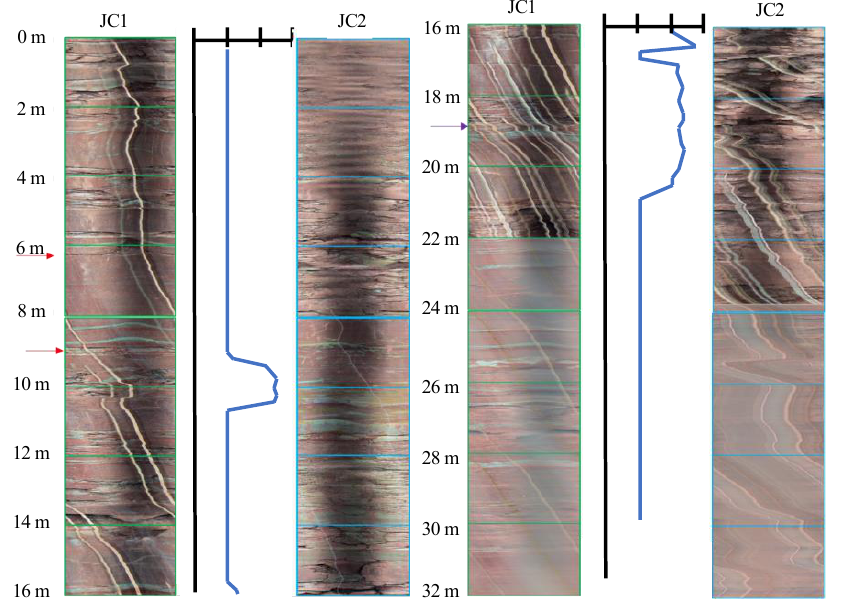
Figure 17. Comparison of borehole images and acoustic velocity measurement (146 m).